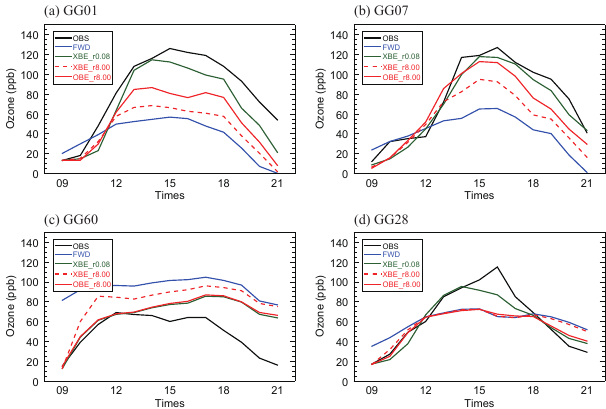
Figure 8. Diurnal variations of surface ozone from the results of EXP_B at (a) GG01, (b) GG07, (c) GG60, and (d) GG28. Black and blue solid lines indicate observation (OBS) and results of forward Figure 10. Model error correlation coefficients between vertical run (FWD), respectively. XBE_r0.08 (green solid), XBE_r8.00 (red levels. The physical height of each level is indicated by the non- dashed), and OBE_r8.00 (red solid) represent 4D-Var run results uniform grid line only in the layer below 1553m, which is the eight with and without considering the background error in matrix form layer of CMAQ. ) is 0.08 and 8.00. where the observation error ( σ obs k